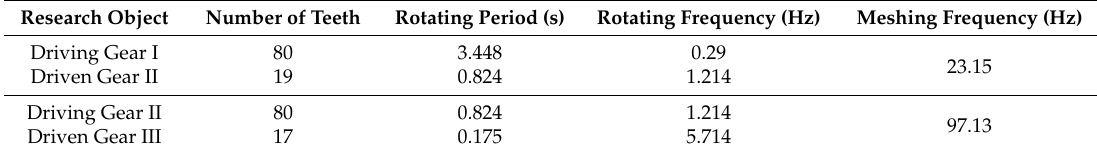
Table 2. Structure parameters of gearbox.